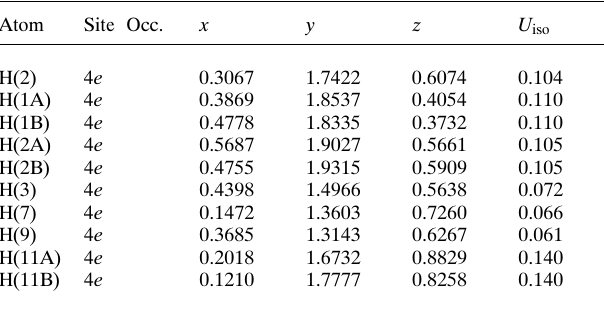
Table 2. Atomic coordinates and displacement parameters (in Å 2 ) . Atom